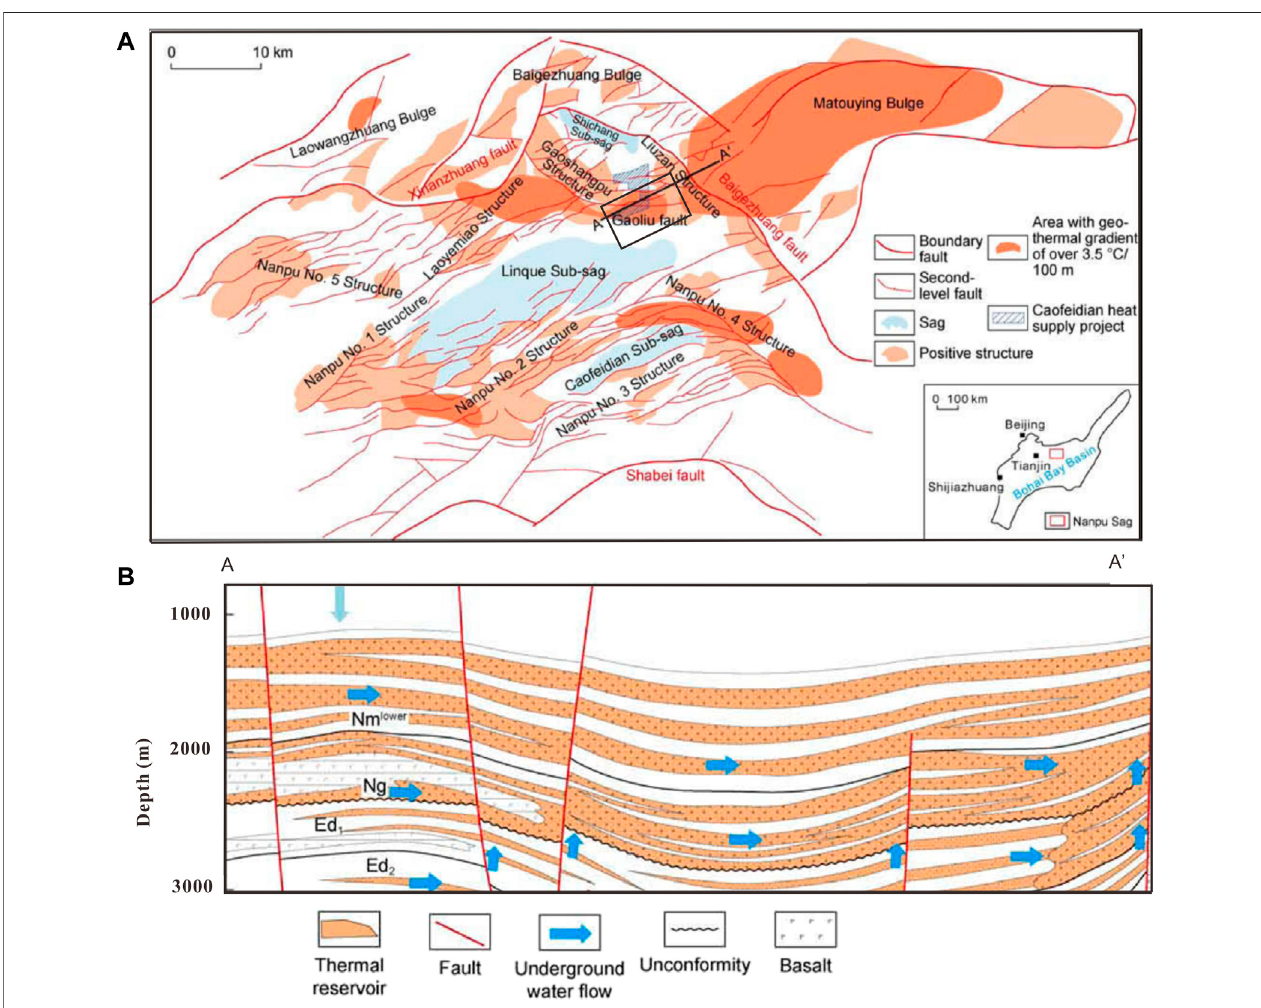
FIGURE 1 | (A) The geological map and distribution of geothermal anomalous zones in the Nanpu sag. The location of Caofeidian new town is also labeled as a black rectangle. (B) Cross-section pro fi le of the Caofeidian new town geothermal fi eld [revised from Dong et al. (2021)].